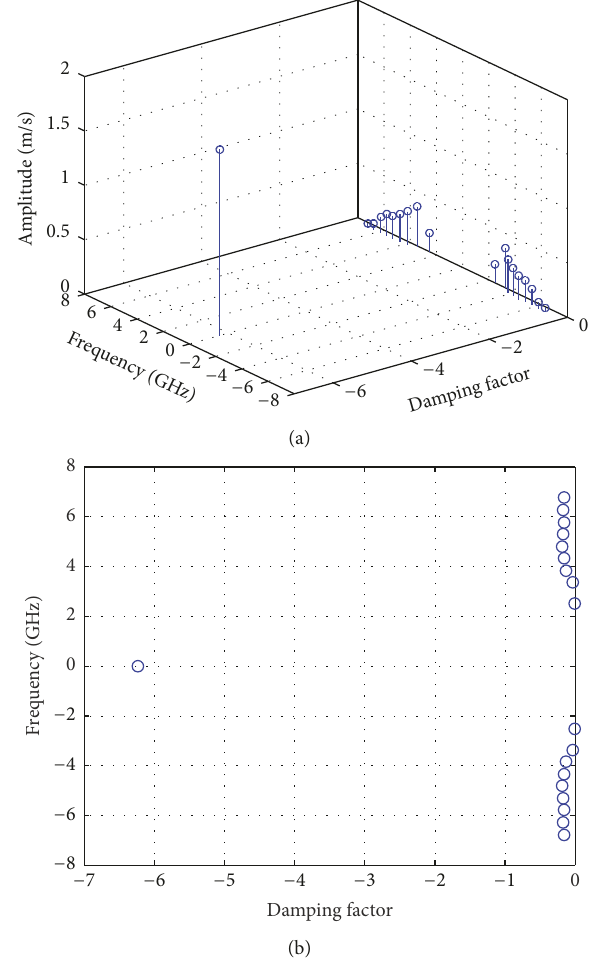
Figure 4: Using classical MP method: (a) pole-residue relationship and (b) frequency versus damping factor of the monopole